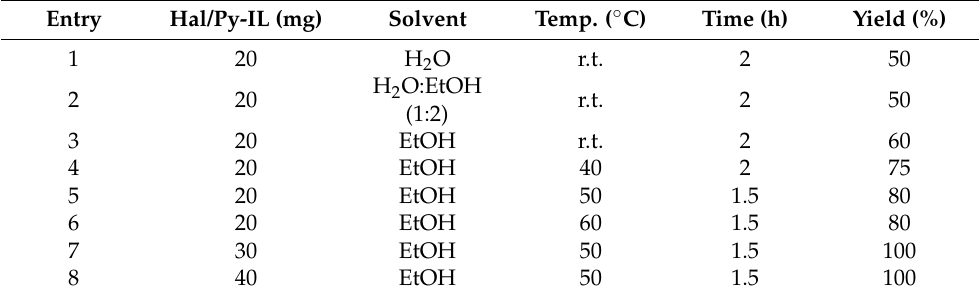
Table 1. Optimization of the reaction variables for the model reaction.